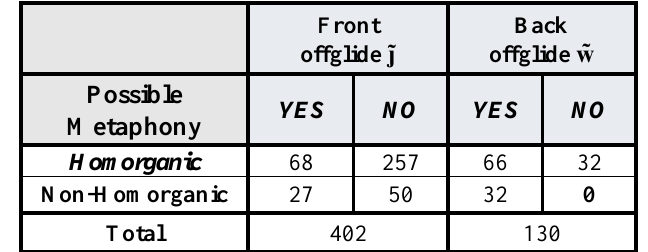
Table 5. Front and back offglides in the corpus according to the possibility of metaphony: homorganic (with the vowel, with the consonant or both) and non-homorganic offglides Front Back offglide j̃ offglide w̃ Possible YES Metaphony